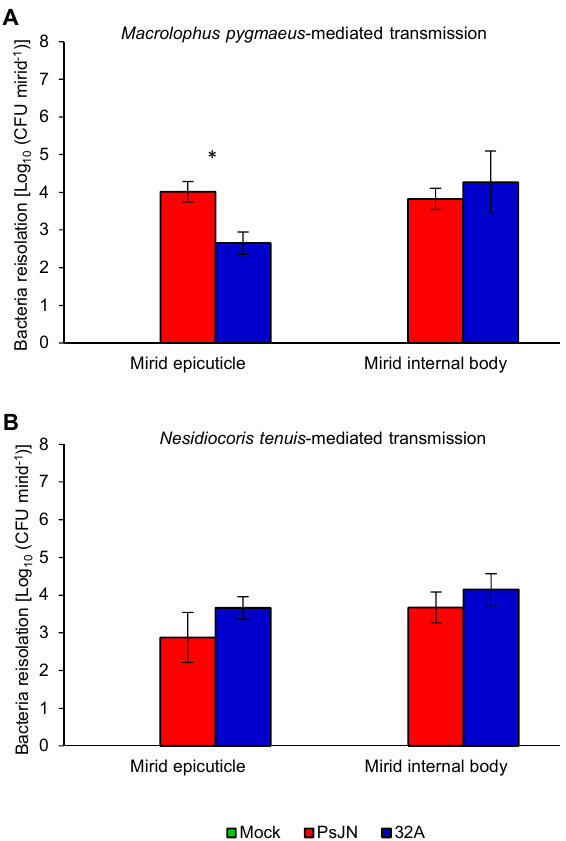
Figure 4. Quantification of endophytic bacterial strains on the mirid epicuticle and internal body. Bacterial re-isolation was carried out from a mirid washing suspension to collect bacteria adhering to the mirid epicuticle or from tissue grinding of surface-disinfected mirids to collect bacteria in the mirid internal body at the end of the mirid-mediated transmission (Day 14) with Macrolophus pygmaeus ( A ) or Nesidiocoris tenuis ( B ). The quantity of re-isolated bacteria is expressed as the colony forming units per mirid (CFU mirid –1 ) fed on mock-inoculated plants (Mock, green) and plants inoculated with Paraburkholderia phytofirmans PsJN (PsJN, red) or Enterobacter sp. 32A (32A, blue). The two-way analysis of variance showed no significant differences between the two experimental repetitions ( p > 0.05) and data from the two experiments were pooled. Mean and standard error values for positive samples and at least nine replicates (mirids) are presented for each treatment. Asterisks indicate significant differences in the pairwise comparisons between the PsJN- and 32A- inoculated samples, according to the Mann–Whitney test ( p ≤ 0.05). Neither PsJN nor 32A bacterial colonies were isolated from mirids fed on the mock-inoculated